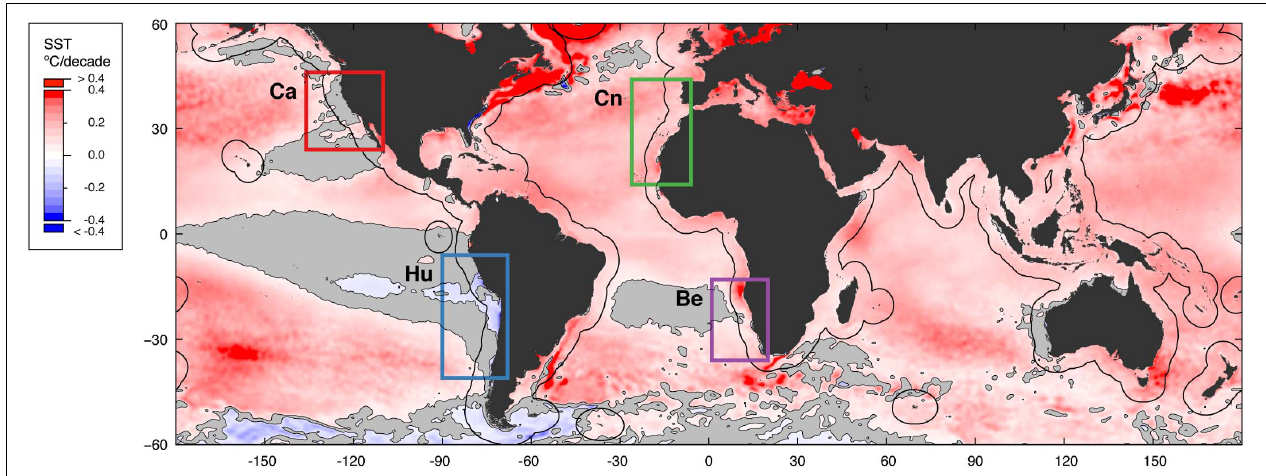
FIGURE 1 | Sea surface warming rates (1982–2018) throughout the global ocean. Colored squares delimit EBUS (Ca: California, Hu: Humboldt, Cn: Canary, Be: Benguela). Black lines offshore from major landmasses and large islands indicate the 500 km distance from land. Gray areas correspond to statistically non-significant rates of SST change at the α = 0.05